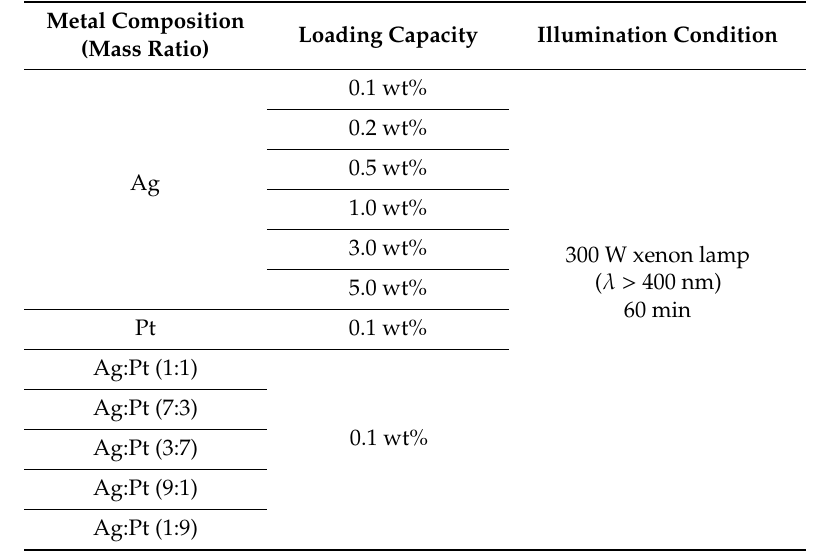
Table 2. Batch compositions of Ag / Bi 4 Ti 3 O 12 , Pt / Bi 4 Ti 3 O 12 and AgPt / Bi 4 Ti 3 O 12